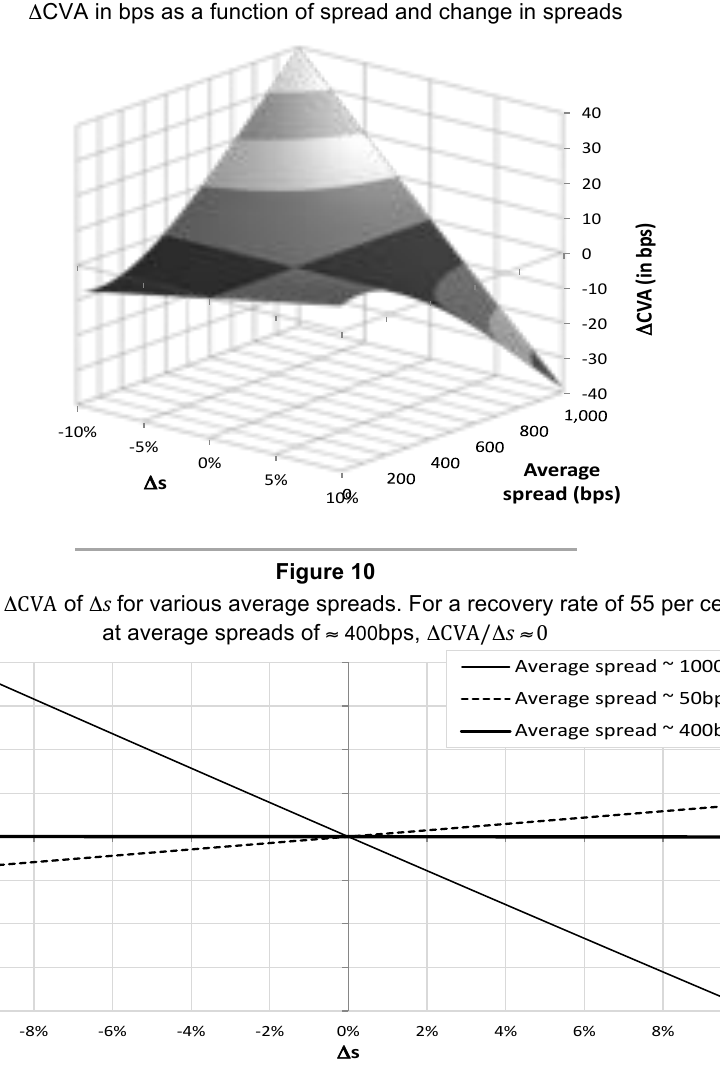
Δ CVA in bps as a function of spread and change in spreads